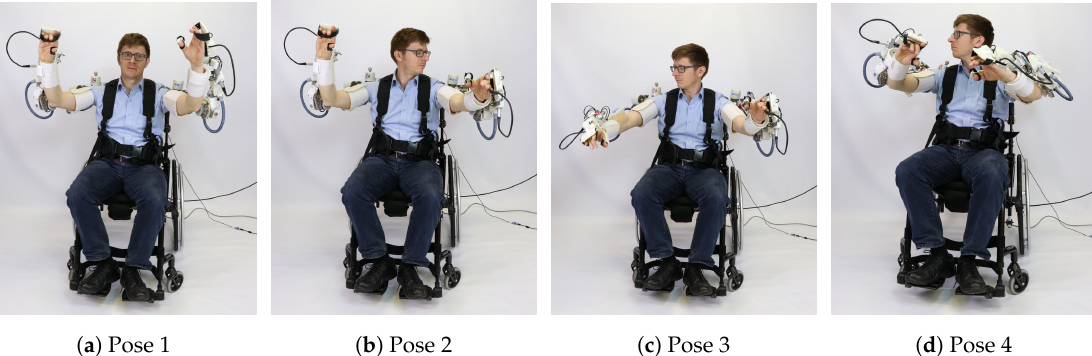
Figure 12. Gravity compensation mode with human subject.